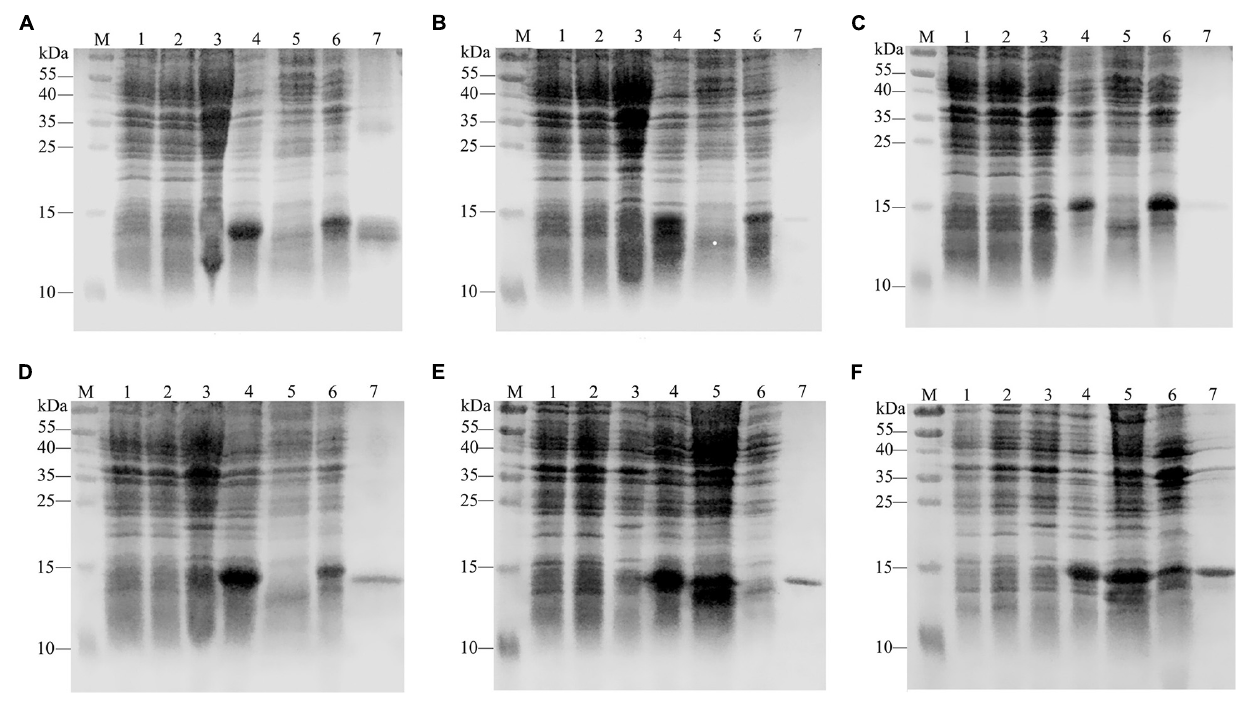
FIGURE 2 | SDS-PAGE analyses showing the expression and purification of four recombinant GdauOBPs and two GdauCSP proteins. (A) GdauOBP1; (B) GdauOBP6; (C) GdauOBP10; (D) GdauOBP15; (E) GdauCSP4; (F) GdauCSP5; M, Protein molecular weight marker; 1, non-induced pET-28a (+); 2, induced pET-28a (+); 3, non-induced recombinant proteins; 4, induced recombinant proteins; 5, supernatant after sonication; 6, inclusion body after sonication; 7, purified recombinant protein.